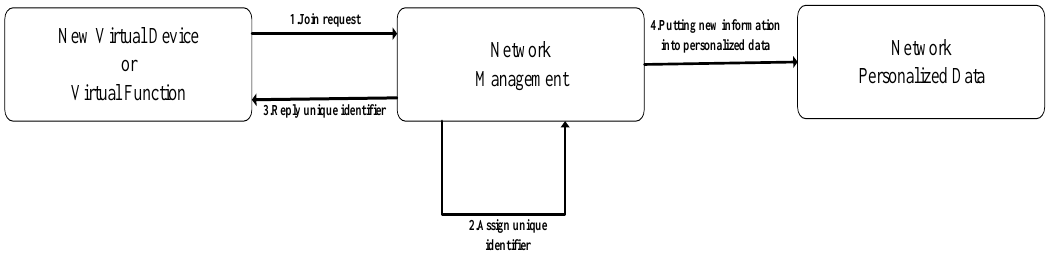
Figure 10. New virtual devices or functions join the network.